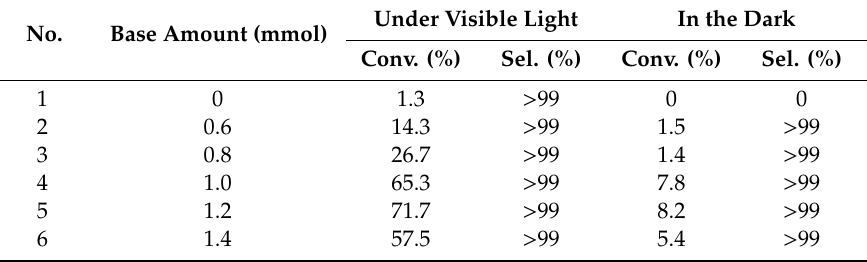
Table 6. E ff ect of di ff erent amounts of base on the reaction of benzyl alcohol and acetophenone. Under Visible Light No.